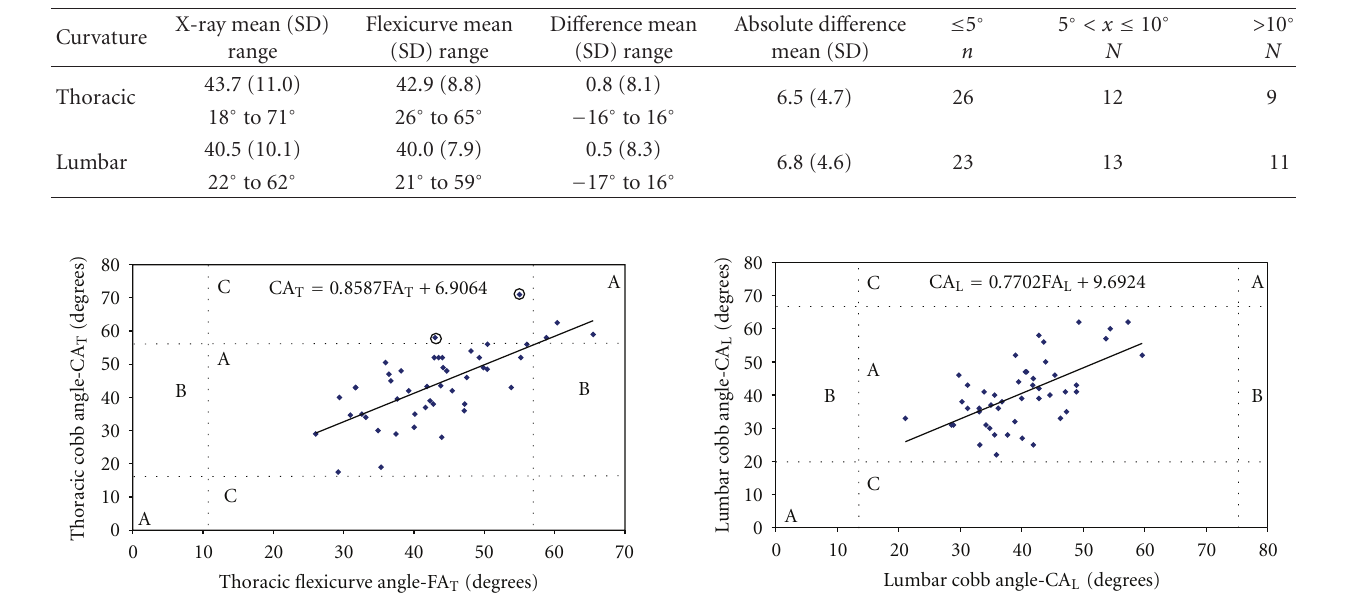
Figure 6: The distribution of the flexicurve angle in relation to the Cobb angle. The vertical and horizontal dotted lines represent the distribution of a normal curvature [31] and divide the figure in 9 zones. The same results are obtained with both techniques in the “A” zones, false positives should appear in “B” zones; false negatives should appear in the “C” zones.